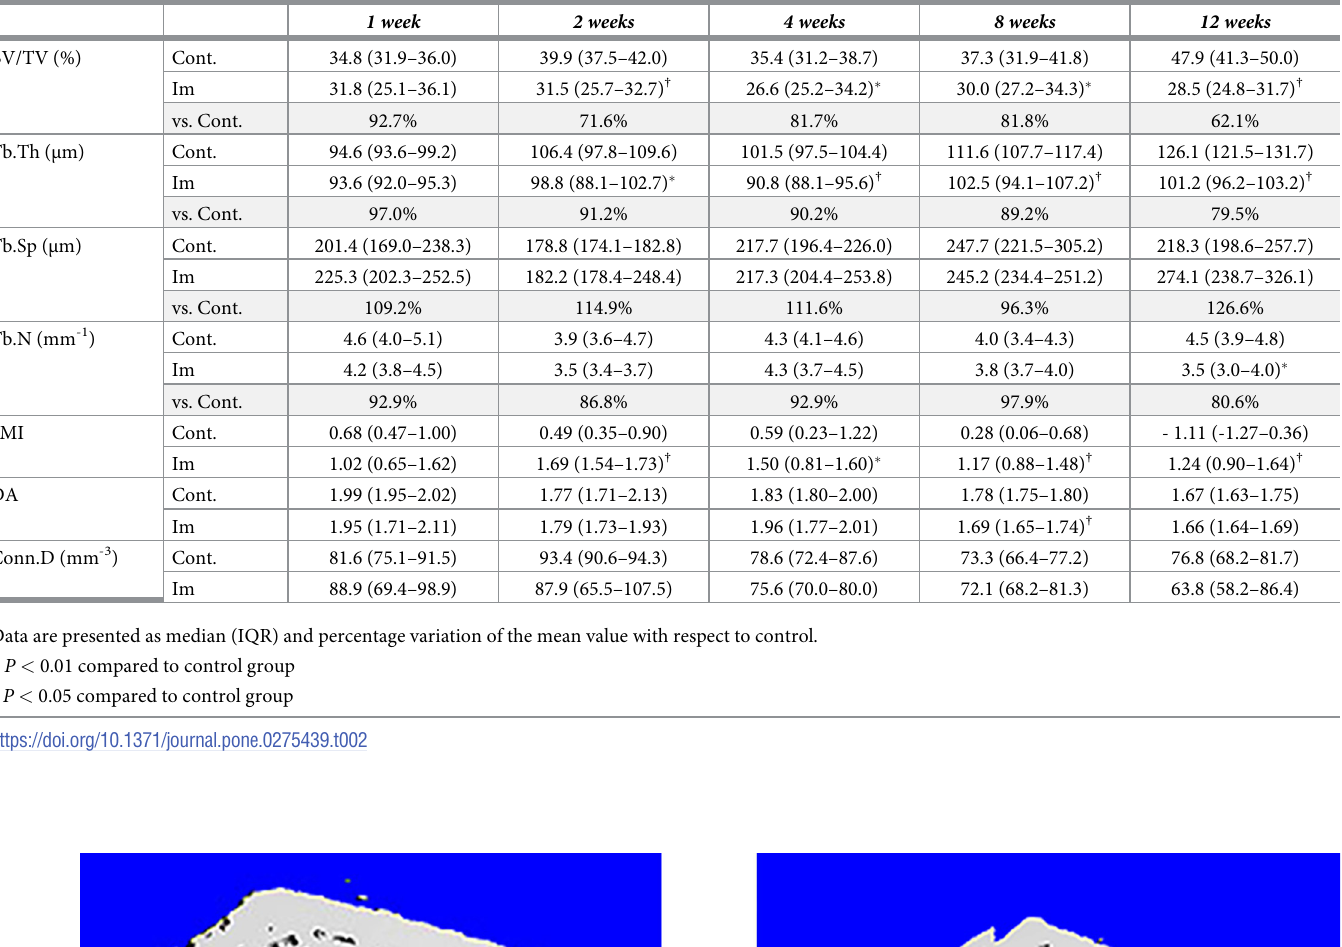
Table 2. Trabecular bone parameters in the distal femoral metaphysis for the two groups at all time points.